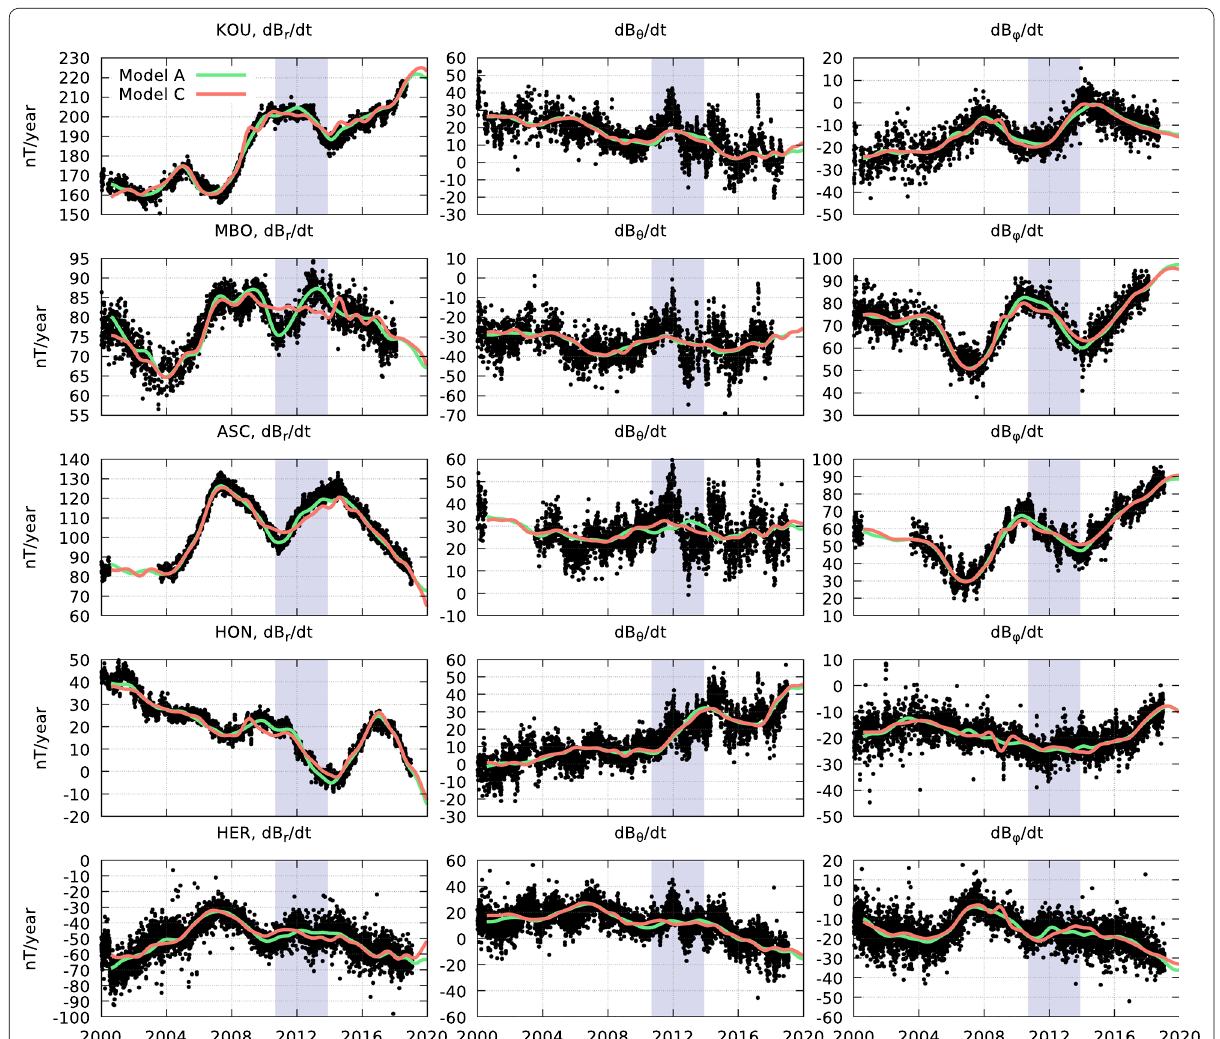
Fig. 8 Secular variation time series for five observatories (Kourou, Mbour, Ascension Island, Honolulu, and Hermanus) in black along with predictions from Model A in green and Model C in red. The blue shaded region indicates the gap period between CHAMP and